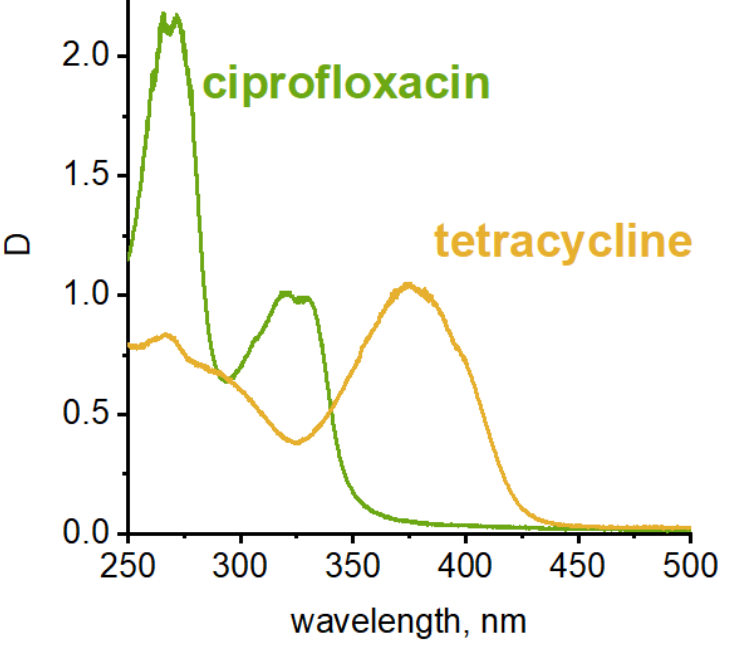
Figure 2. UV-vis spectra of tetracycline and ciprofloxacin.